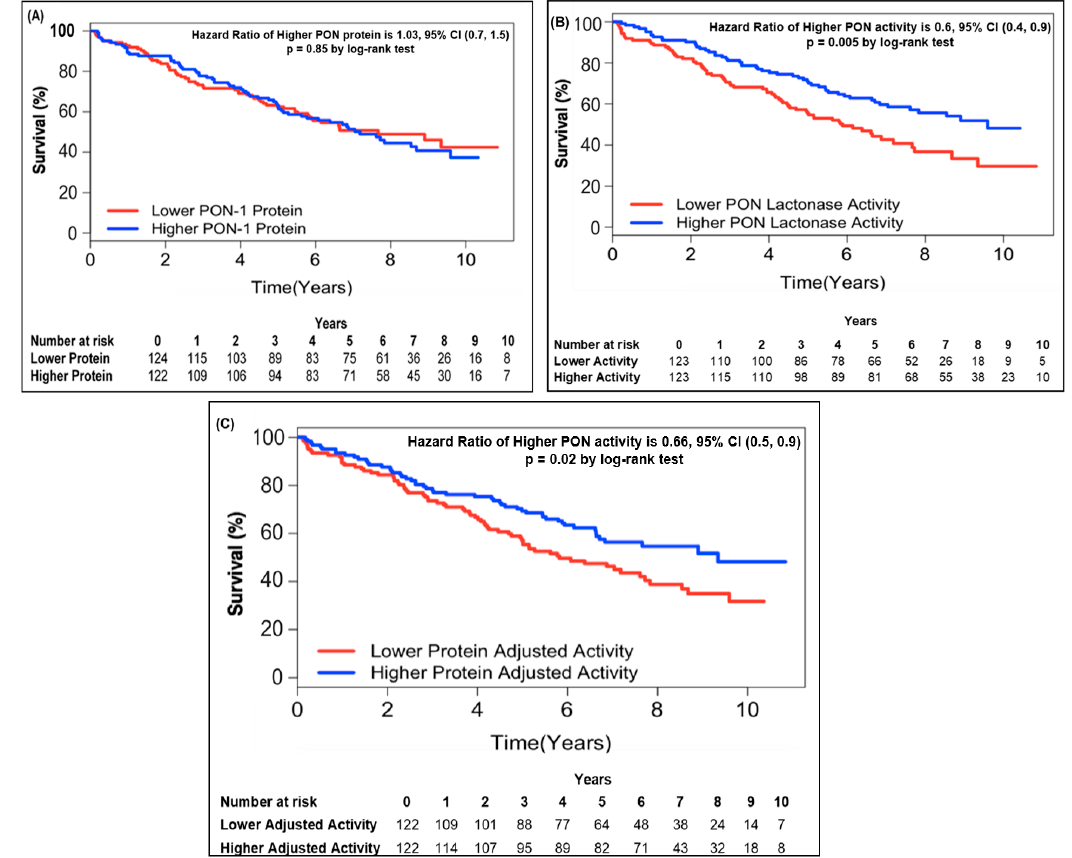
Figure 2. Kaplan–Meier analysis for mortality by PON ‐ 1 protein ( A ), PON lactonase activity ( B ), and PON protein adjusted lactonase activity ( C ) in patients with CKD. Patients were stratified according to optimal cut ‐ off as follows: Lower PON ‐ 1 protein ≤ 333.4 (ng/mL) and higher PON ‐ 1 protein > 333.4 (ng/mL); lower PON lactonase activity ≤ 2073 (pmol/min/mL) and higher PON lactonase activity > 2073 (pmol/min/mL); lower protein adjusted lactonase activity ≤ 6.22 (pmol/min/ng) and higher protein adjusted activity > 6.22 (pmol/min/ng).